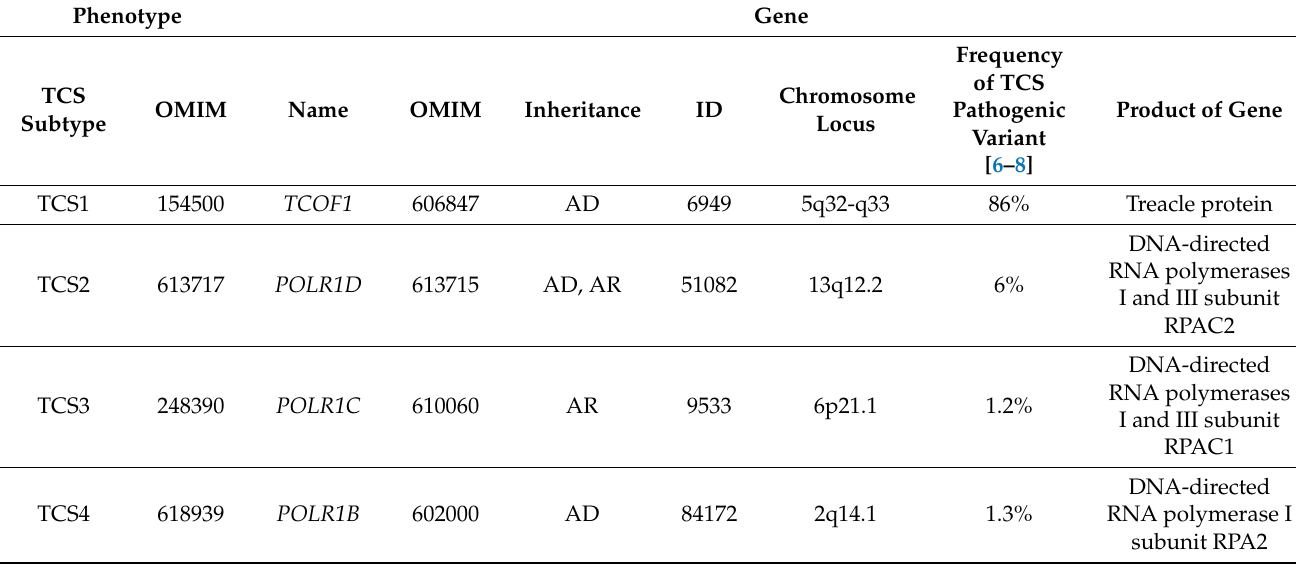
Table 1. Classification of genes and subtypes of Treacher Collins syndrome (TCS) (ORPHA: